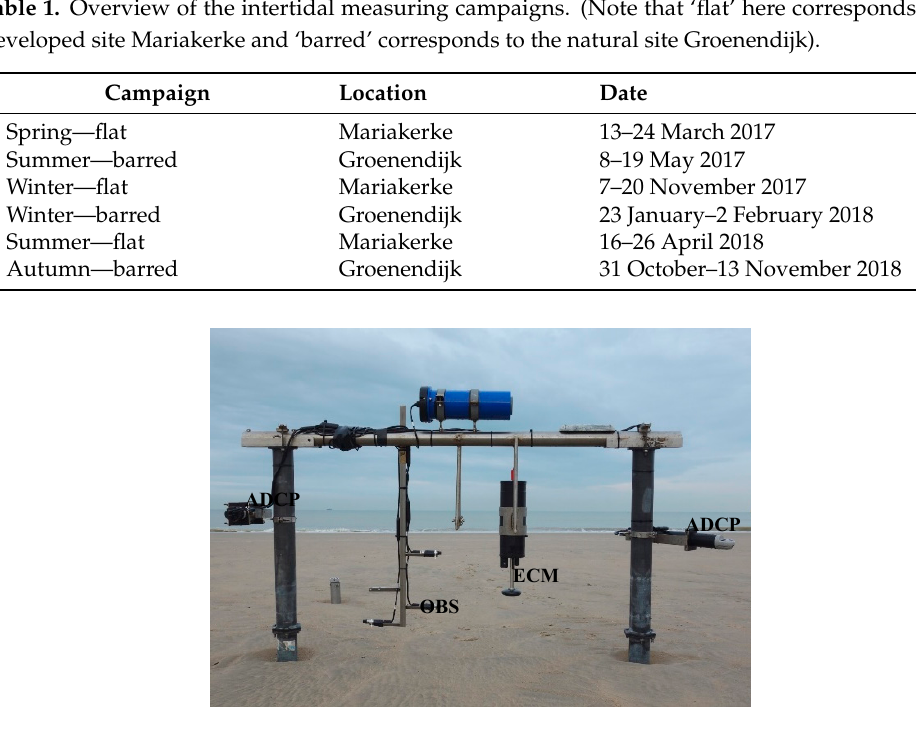
Figure 2. The intertidal measuring frame (1 m high, 2.2 m wide) with (from left to right) the down-looking ADCP, the OBS, the ECM, and the up-looking ADCP. Table 1. Overview of the intertidal measuring campaigns. (Note that ‘flat’ here corresponds to the developed site Mariakerke and ‘barred’ corresponds to the natural site Groenendijk.)